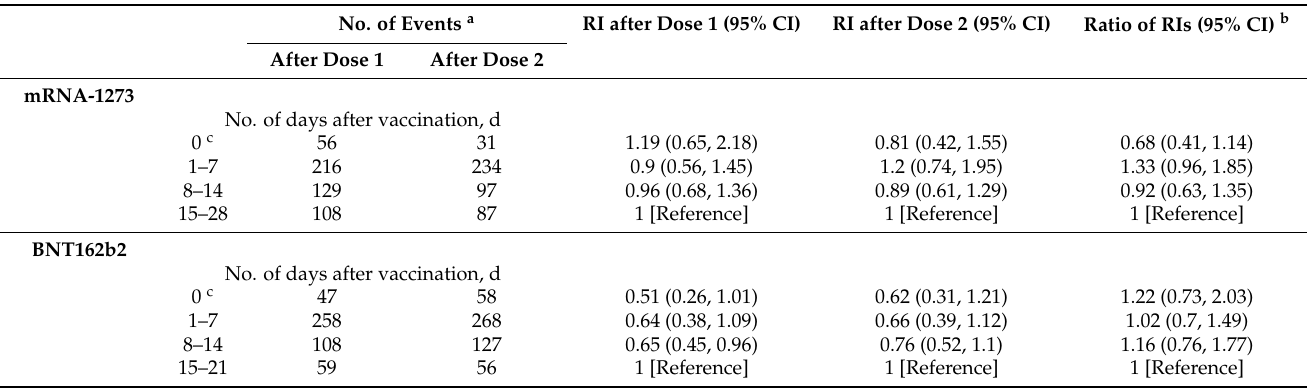
Table 2. Ratios of relative incidences and relative incidences of venous thromboembolism after two doses of COVID-19 mRNA vaccine.